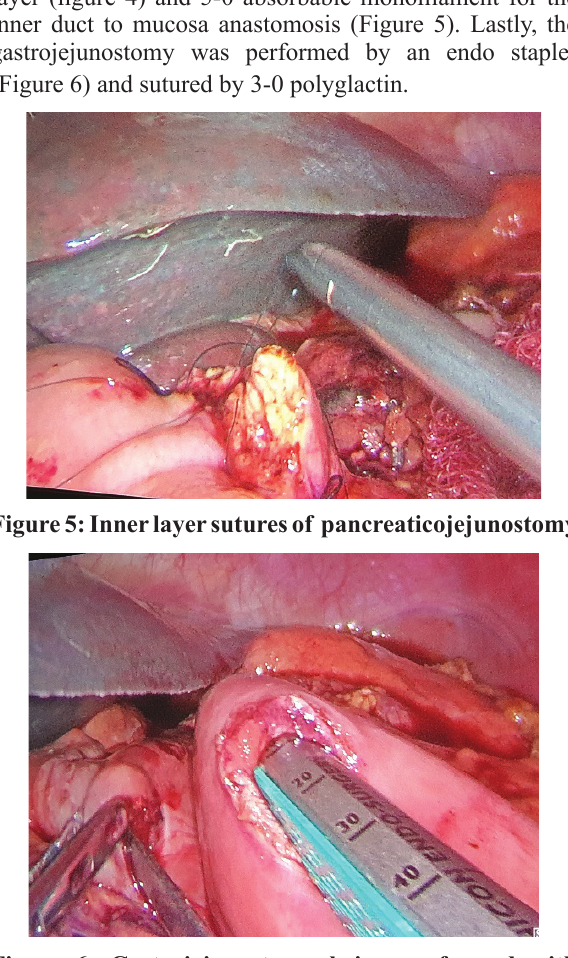
Figure 6: Gastrojejunostomy being performed with